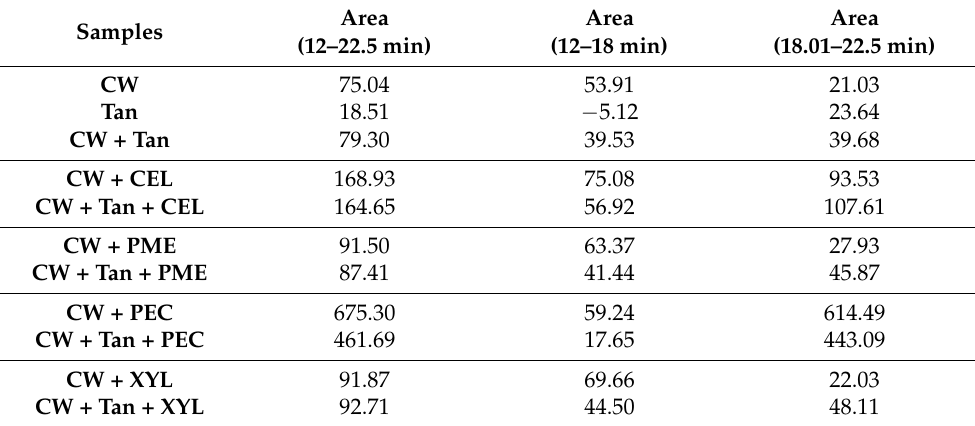
Table 5. Total area, high and medium molecular mass polysaccharides (those eluting from 12 to 18 min) and low to medium molecular mass polysaccharides (eluting from 18.1 to 22.5 min) measured in the size exclusion chromatography analysis for the polysaccharides liberated from the cell-walls in the adsorption tests.